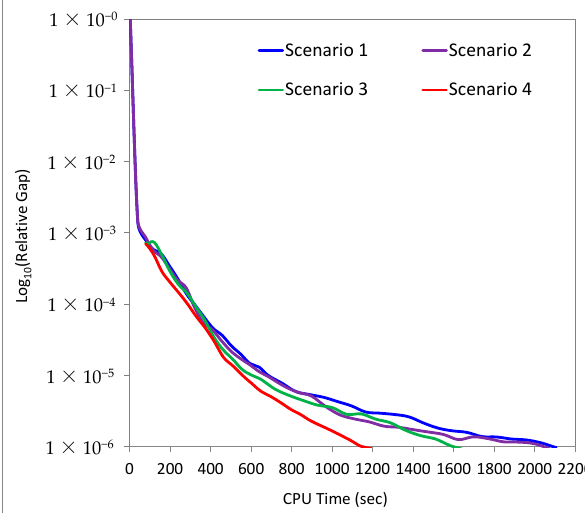
Figure 8. Convergence